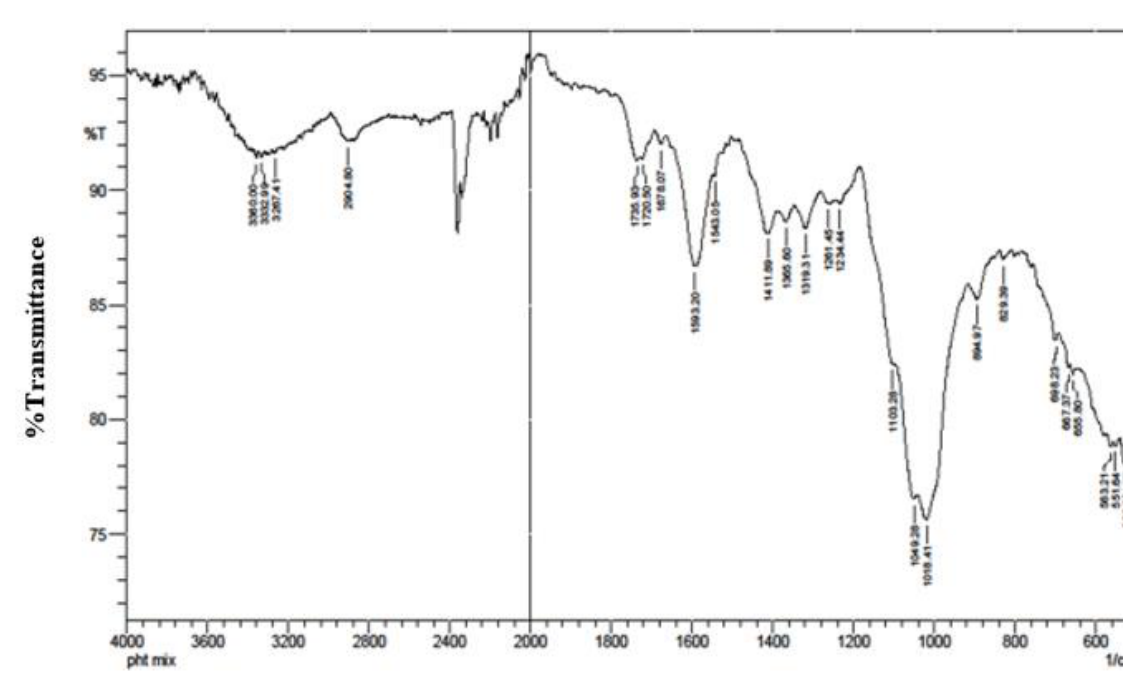
Figure 5. FTIR spectrum of CCS